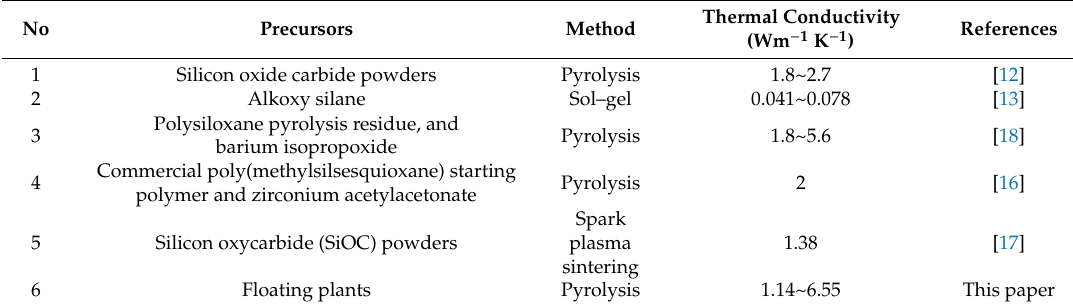
Table 3. Comparison of thermal conductivity with other